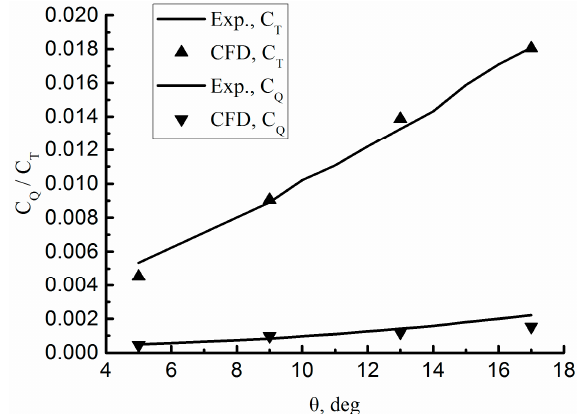
Figure 3. Comparison between the predicted and experimental results for the thrust and torque coefficients.